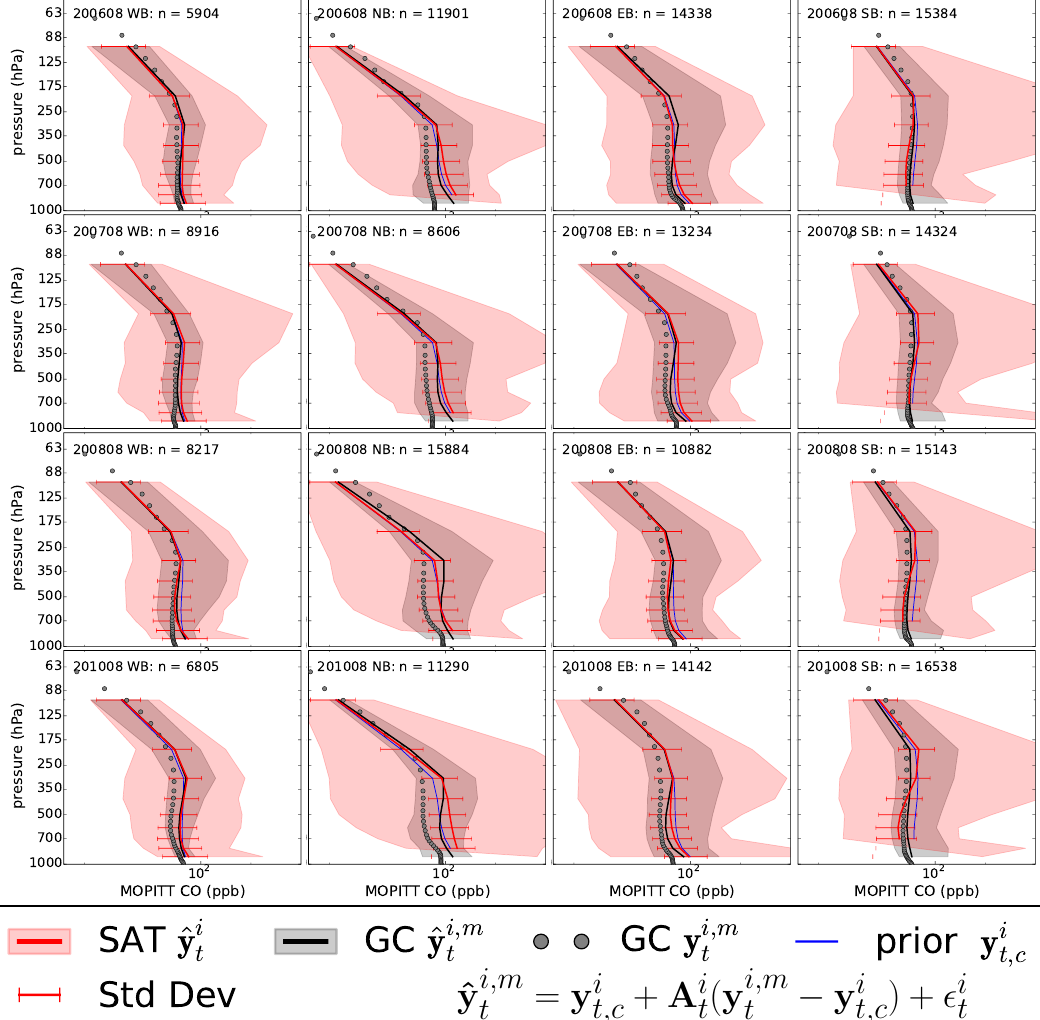
Fig. A6. Same as Fig. A2, but for MOPITT; does not have year 2009, and includes year 2010. Table A1. Carbon Bond ’05 (CB05) species mapping in the form CB05 Species, GEOS-Chem expression. O 3 , O x –NO